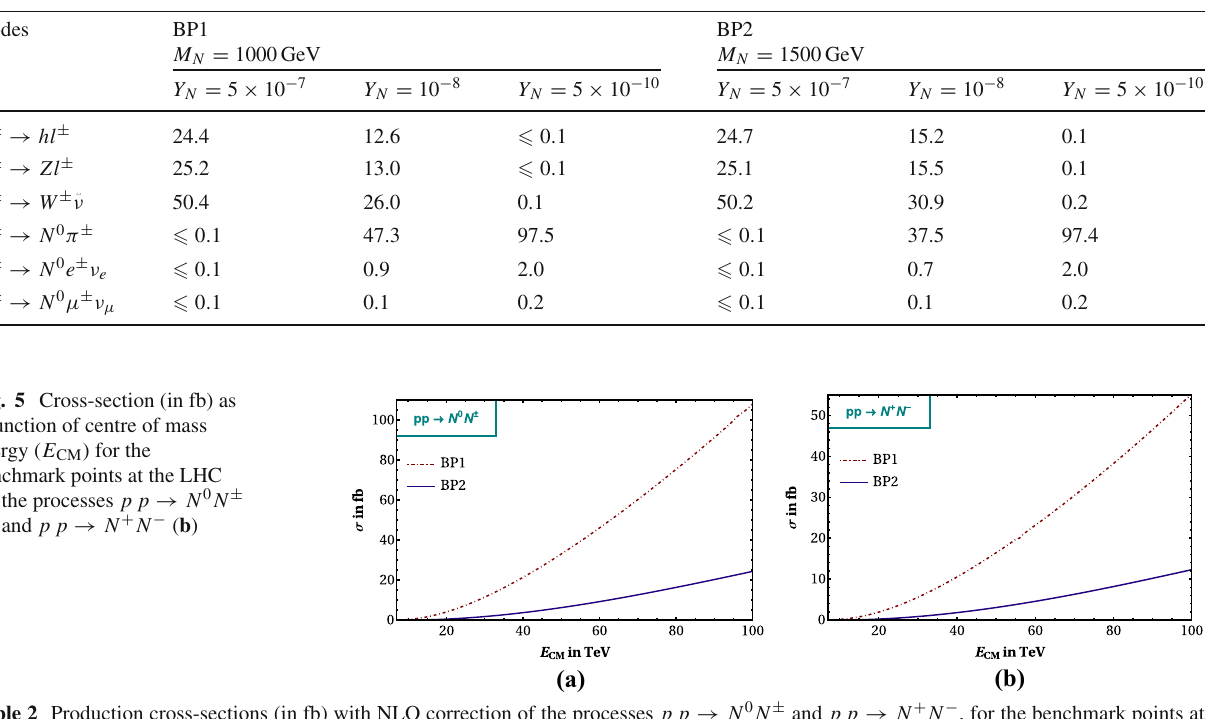
Fig. 4 a CMS[29]and b ATLAS[28]boundsontheType-IIIfermions when only one generation is light. The black dashed lines are the expected medians whereas the green and yellow bands present the 1 σ